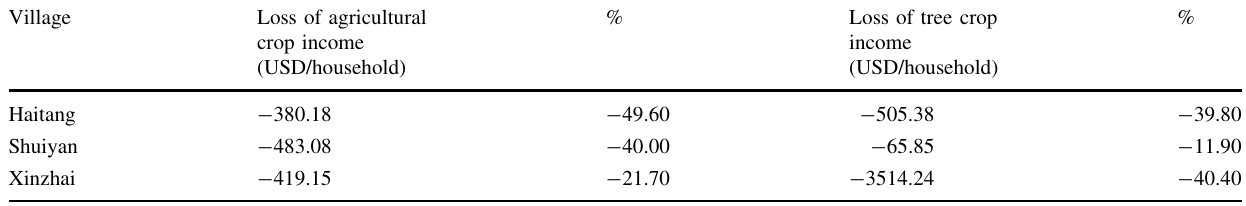
Table 4 Losses in agricultural versus forestry income in the spring season, 2009–2010, in Longyang County, Yunnan Province, China. Source Su et al. (2013) (Household survey, 2010)